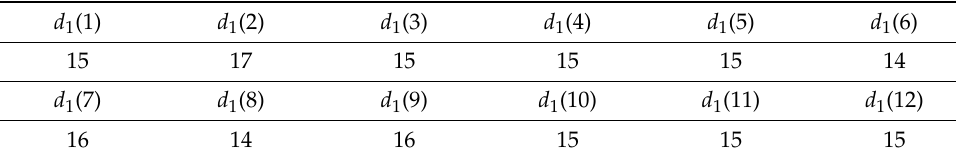
Table 2. Average demand 2.